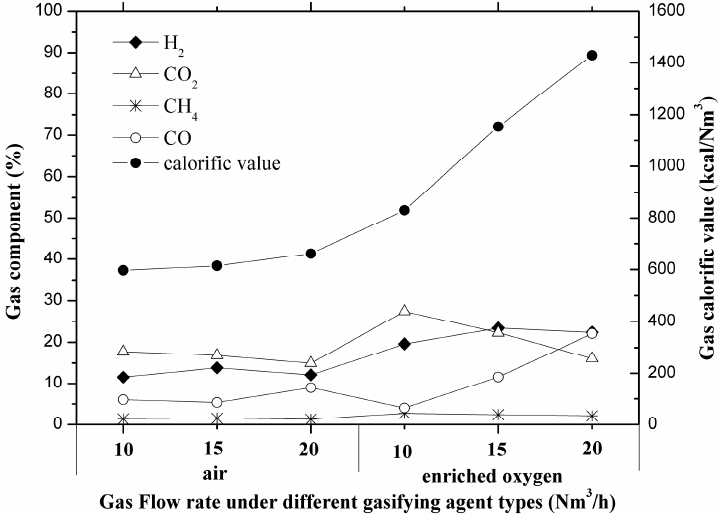
Figure 5. Changes of gas components during the reverse UCG process with air and enrich oxygen as the gasifying agent at different flow rates.